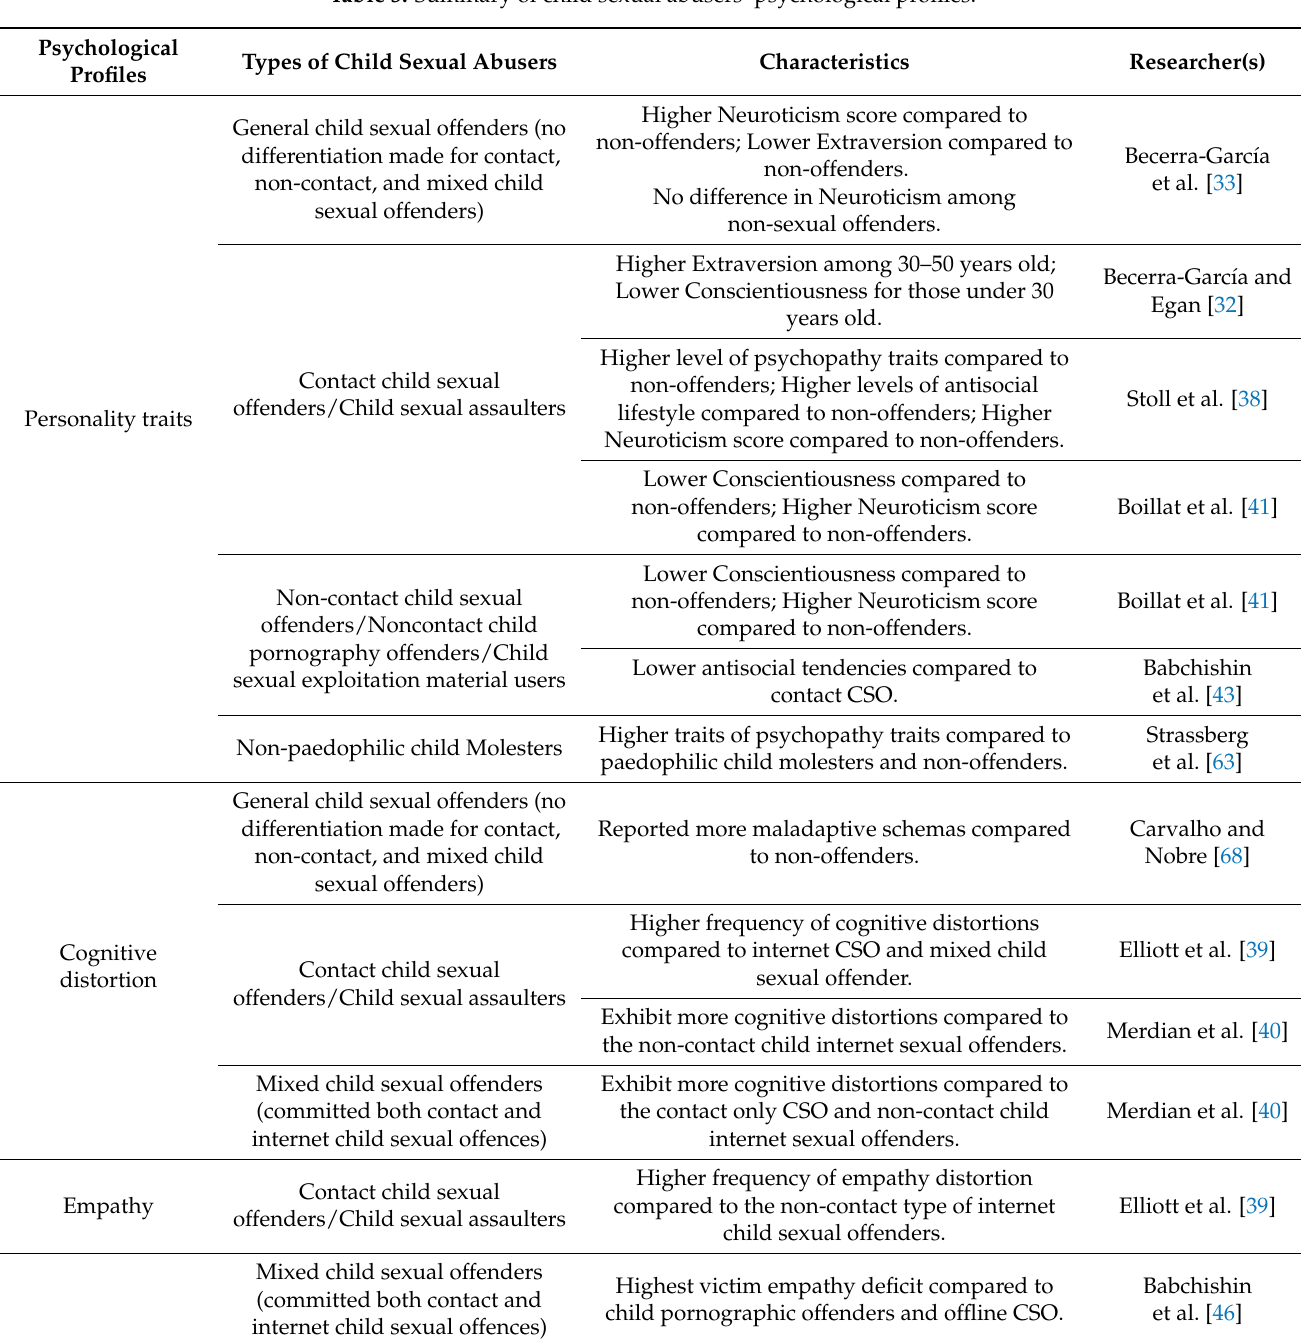
Table 3. Summary of child sexual abusers’ psychological